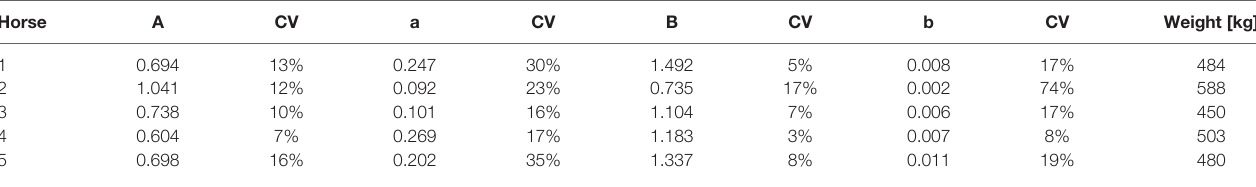
TABLE 1 | Independently estimated macro constants and their standard errors are shown along with the respective horse weights.